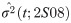
Cross-sectional variance v intra-day time in 2S08.As employed for the individual analysis we use the lighter(darker) tone of green for the morning(afternoon) part of the curves σ2^(t;2S08). For mere comparative purposes we present the individual analysis σ2˜(t;2S08) in grey.